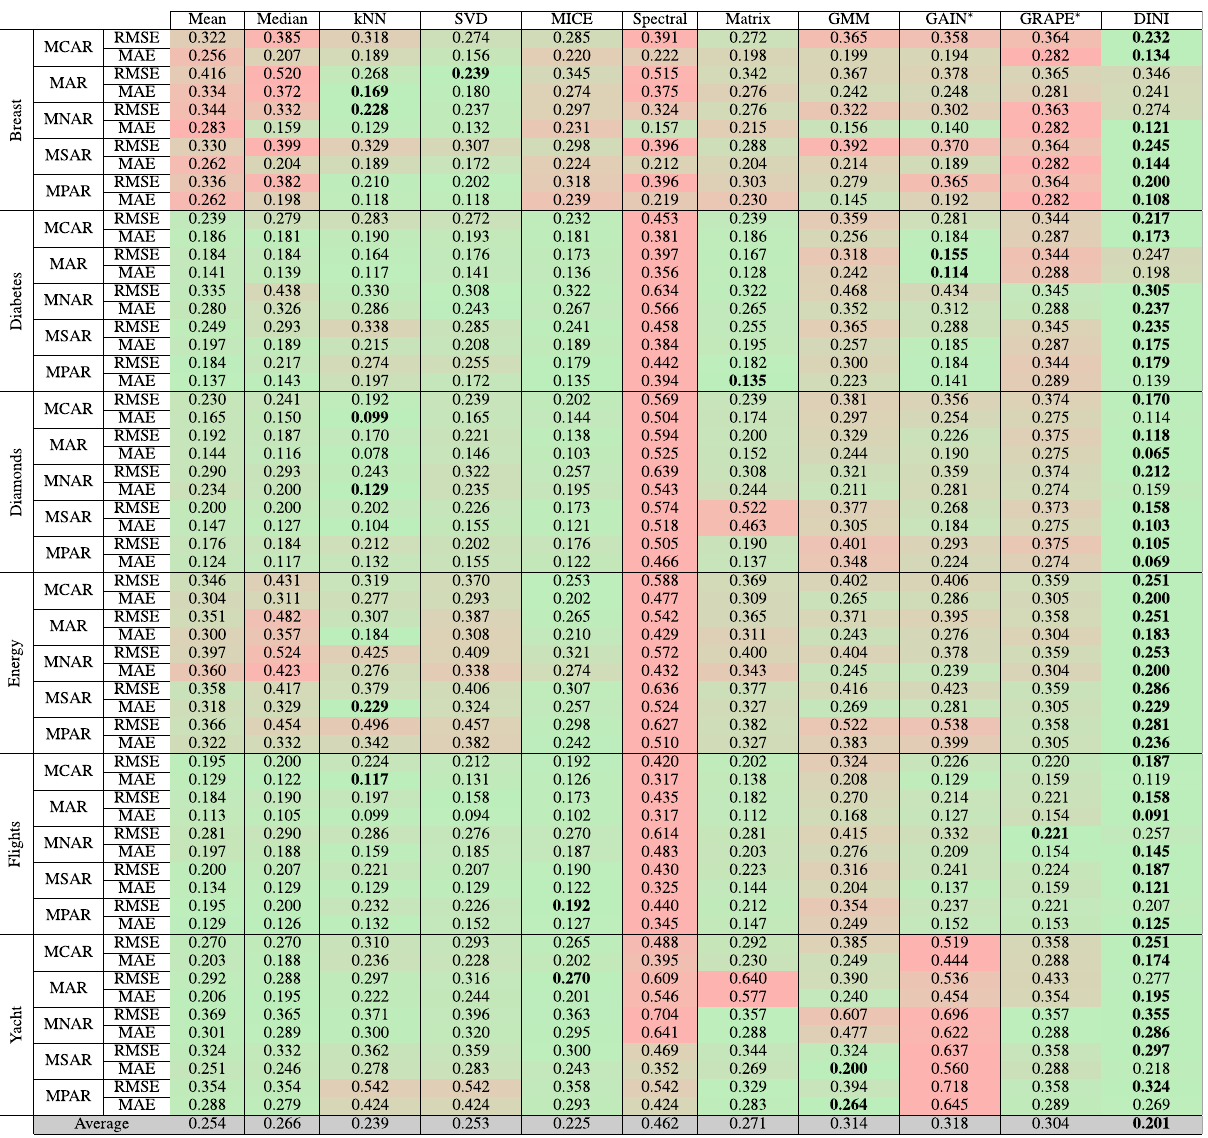
Table 2. Comparison of imputation performance of DINI with various baselines. Six datasets and five (including two newly proposed) corruption strategies are considered. The last row averages all entries for each column (including both RMSE and MAE values). Confidence intervals are not shown to conserve space. Values corresponding to the lowest error are in